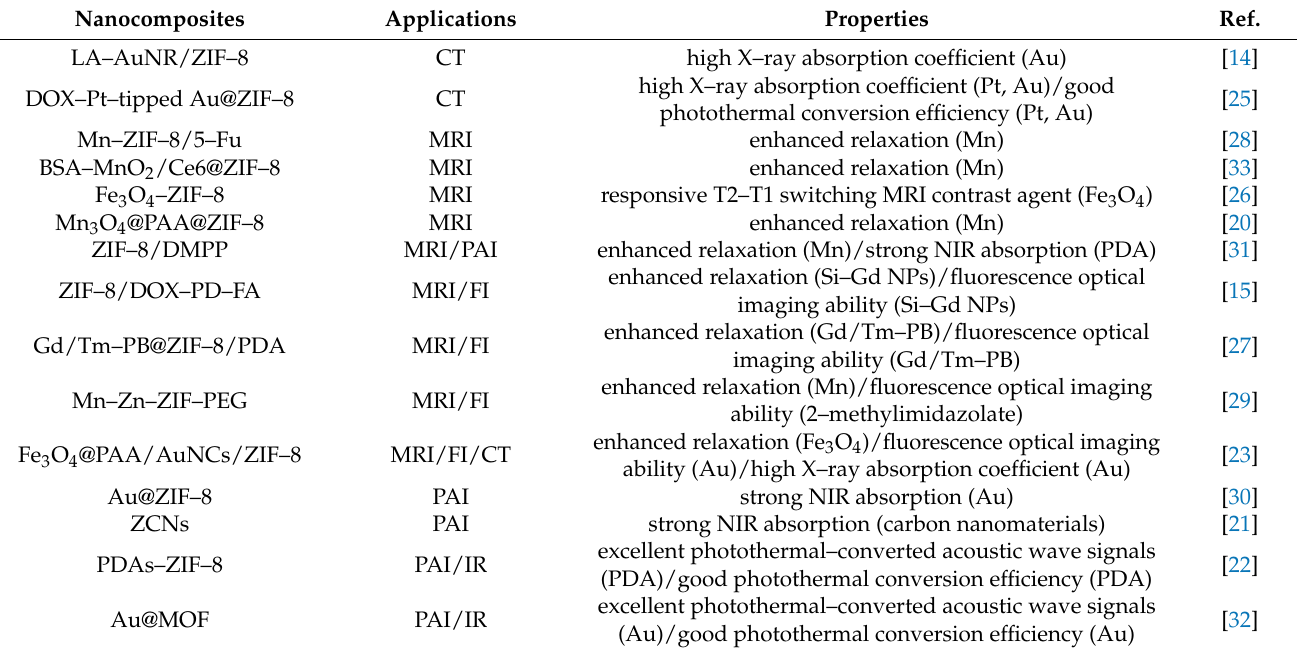
Table 1. Recent studies on ZIF–8–based nanoplatforms for biomedical